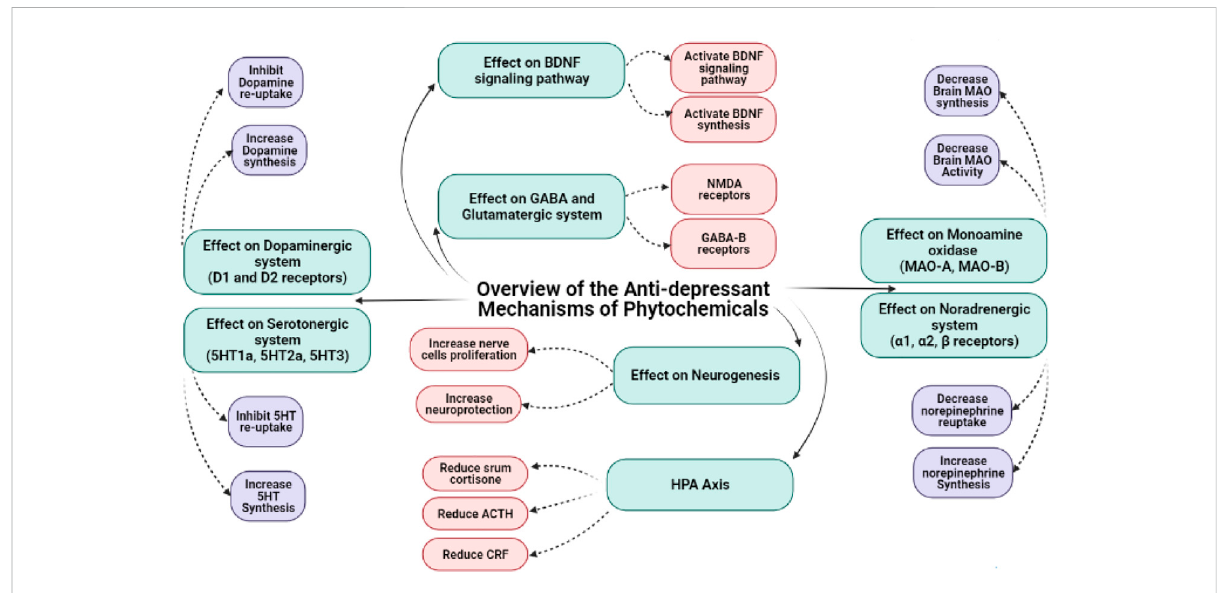
Overview of the anti-depressant mechanisms of